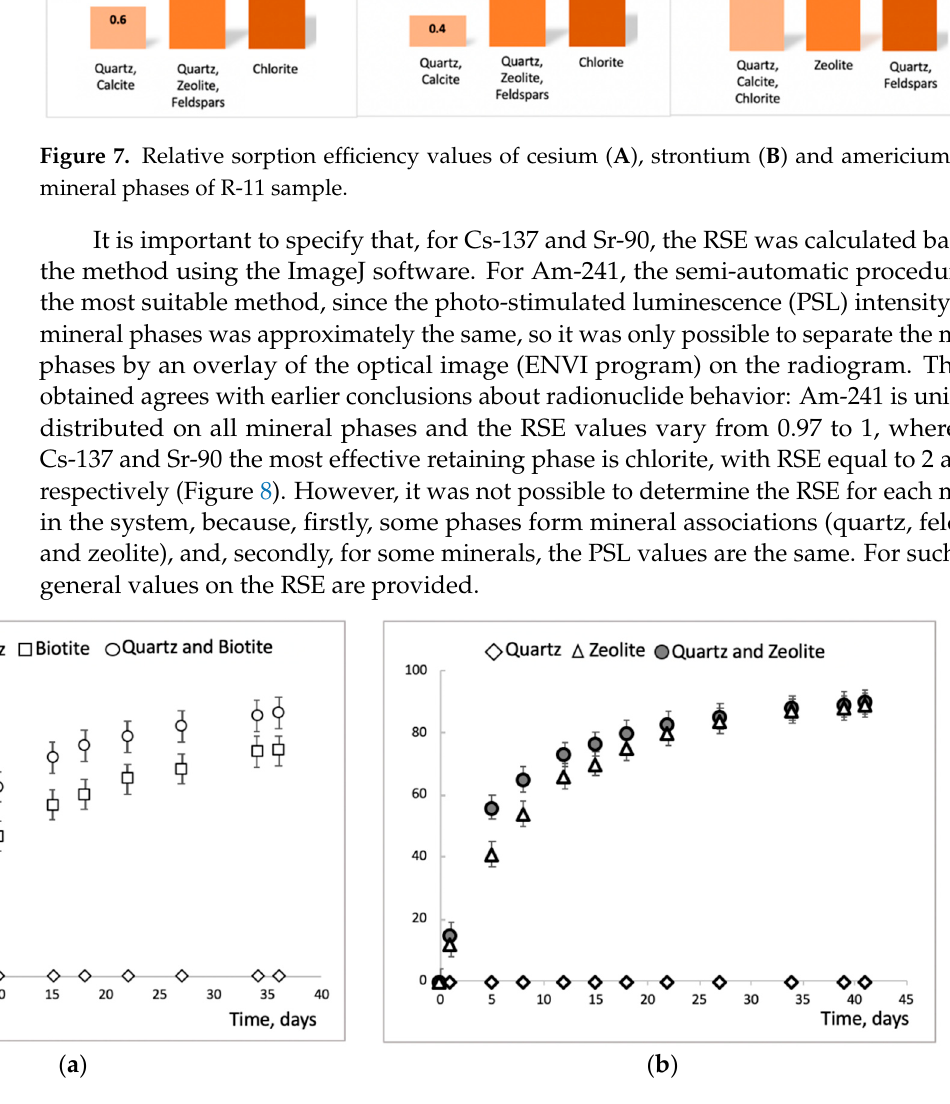
Figure 6. Cesium ( a ) and strontium ( b ) distribution in the fracture zone of R-11 sample (radiogram on the left, SEM images on the right); Chl—chlorite phase (the main filler of cracks).